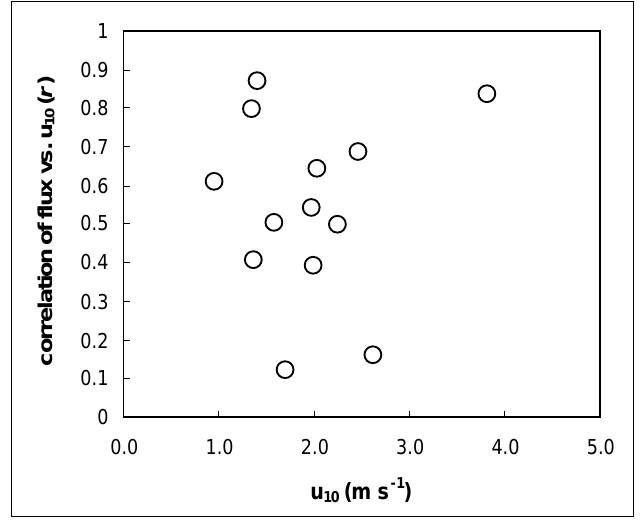
Figure 6. The relationship between the correlation of Hg air / surface exchange flux with wind speed ( u 10 ) for each sampling day and the corresponding daily mean wind speed.